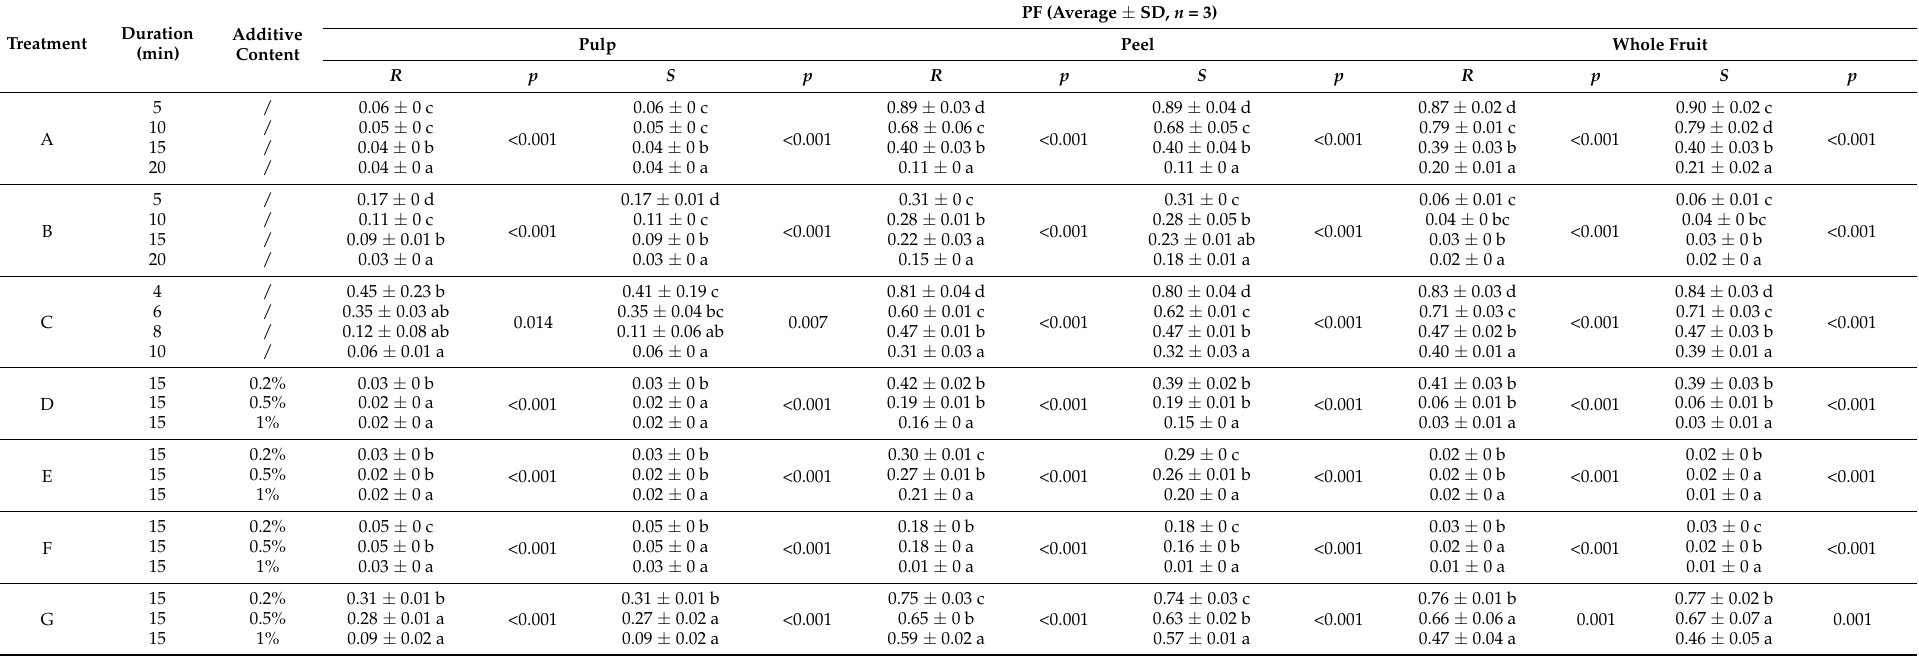
Table 3. PF values of penthiopyrad enantiomers in cucumber samples after different soaking